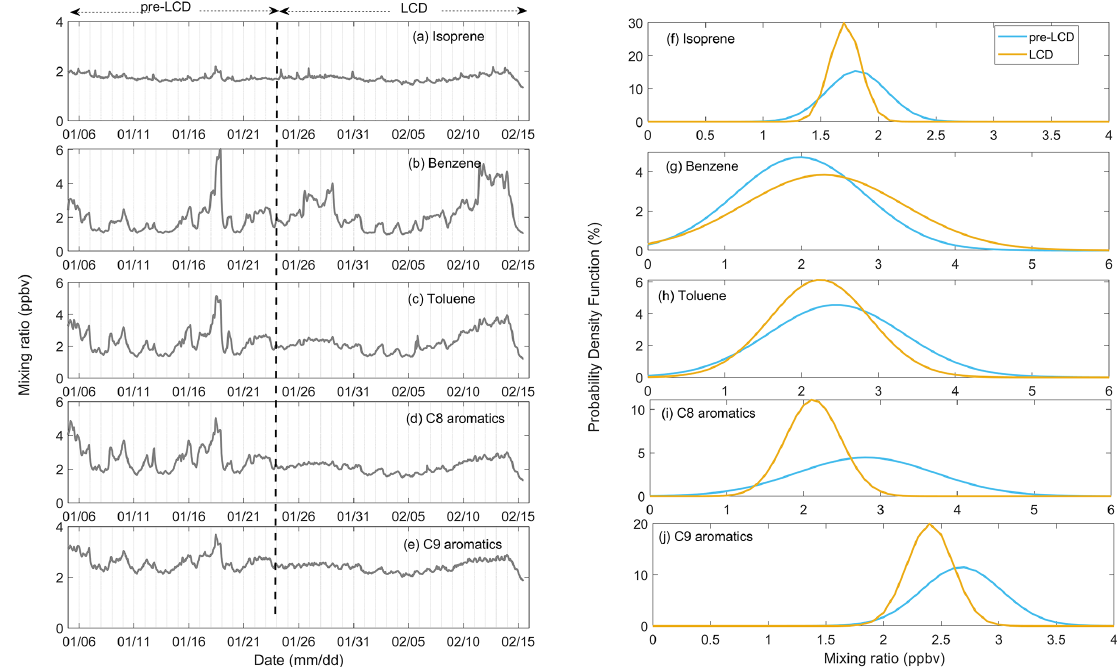
Figure 5. Time series of isoprene, benzene, toluene, and C8 and C9 aromatics (a–e) during 5 January to 15 February, and the probability distribution function of mixing ration of each VOC component (f–j) , respectively.